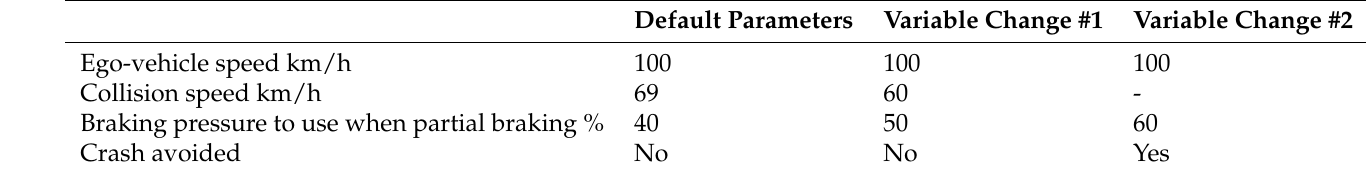
Table 1. Comparison of the effect of braking pressure change during partial